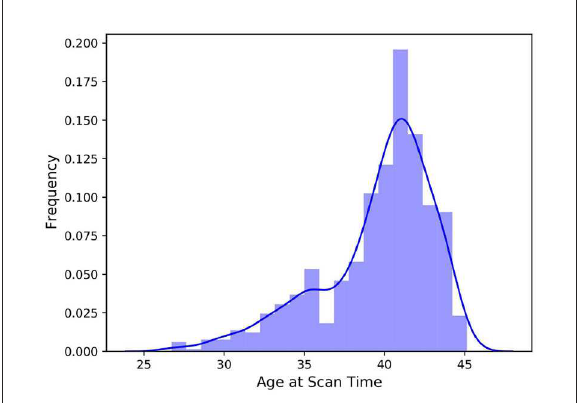
FIGURE1 Histogram of the distribution of scan ages in the full dHCP dataset consisting of 709 samples. The added kernel density estimate highlights the bimodal distribution of the